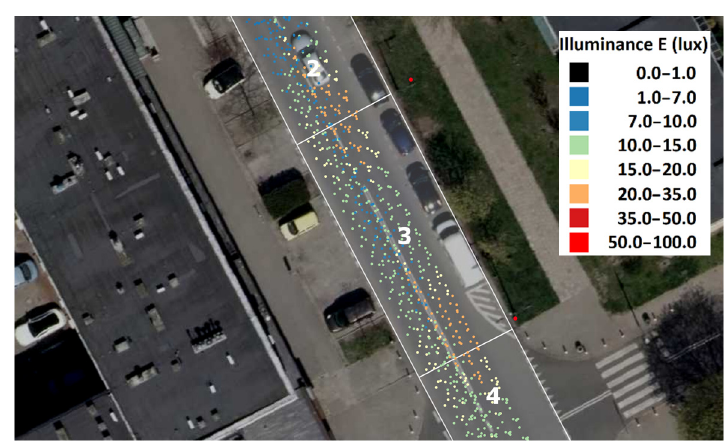
Figure A2. Example of five illuminance measurements in field No. 3.